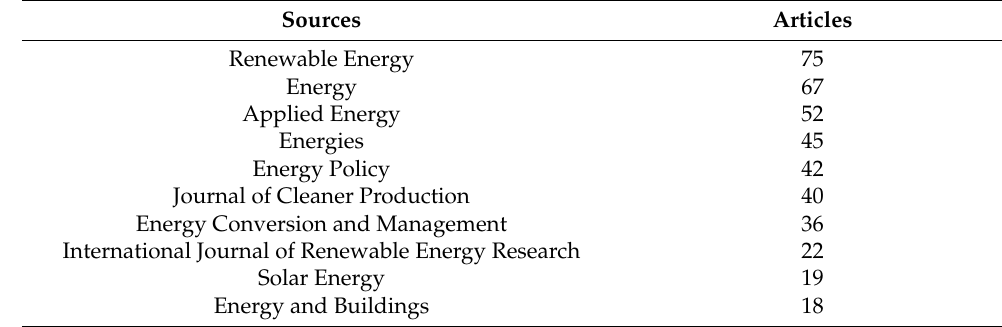
Table 5. Papers by Source (TPEM).